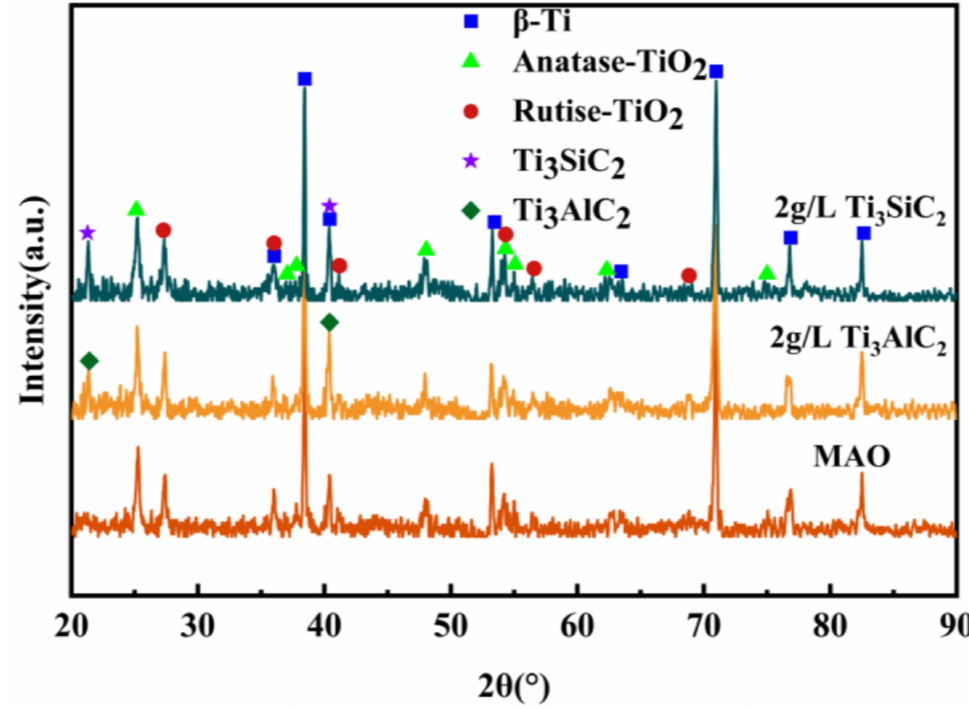
Figure 4. X-ray diffraction patterns of MAO layer on TC4 alloy with different particle